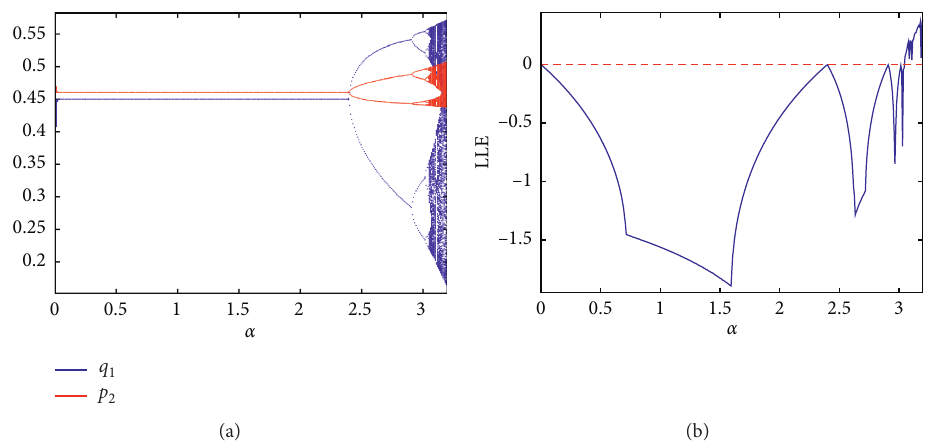
Figure 3: (a) Bifurcation diagram and (b) LLE with respect to α when β �